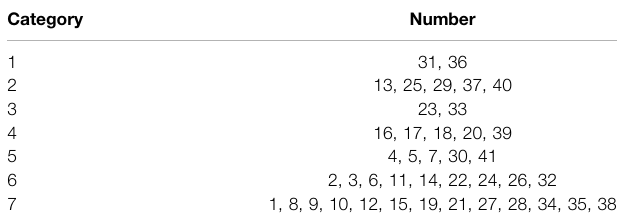
TABLE 3 | Clustering results of fl uctuation process.